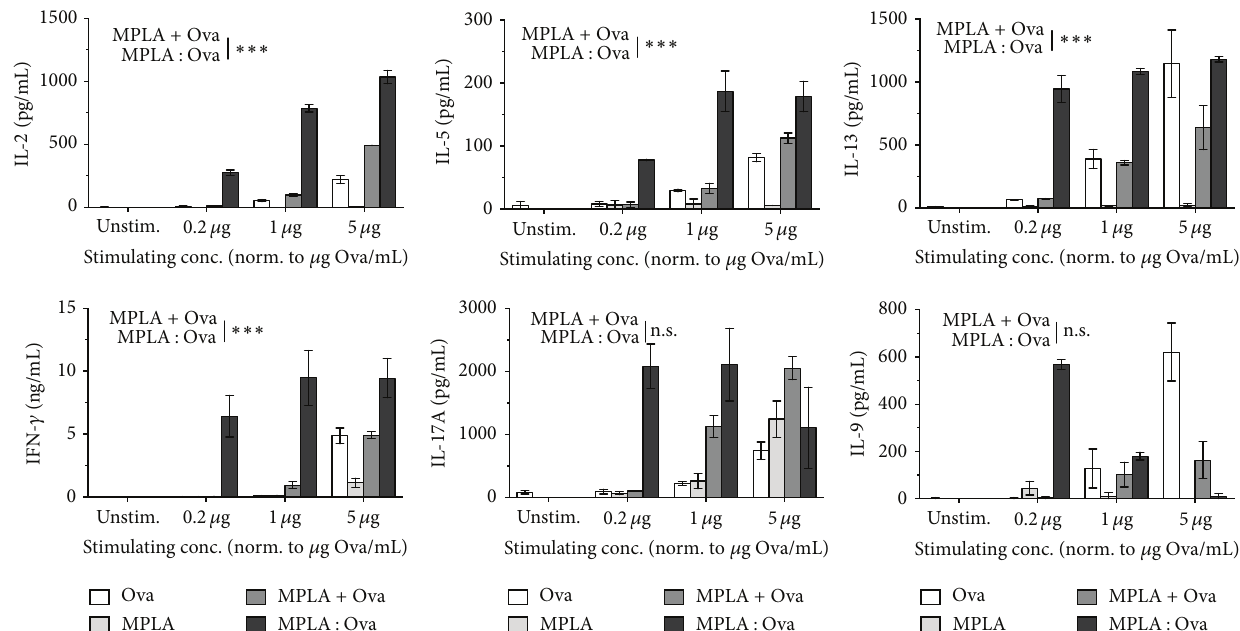
Figure 3: The MPLA:Ova fusion protein nonspecifically boosts Th1, Th2, and Th17 cytokine secretion from Ova-specific T cells. Cytokine secretion from BALB/c mDC (3.2 × 10 5 cells/mL) and DO11.10 CD4 + T cell (8.0 × 10 5 cells/mL, > 95% purity) cocultures stimulated with Ova (white bars), MPLA (light grey bars), MPLA + Ova (dark grey bars), or MPLA: Ova (black bars) for either 24 h (IL-2) or 72 h (all other cytokines). ELISAs were performed using either BD OptEIA ELISA (BD Biosciences) or Ready-SET-Go! ELISA Sets (eBiosciences). Data are mean results of two independent experiments ± SD. Statistical analysis was performed according to Figure